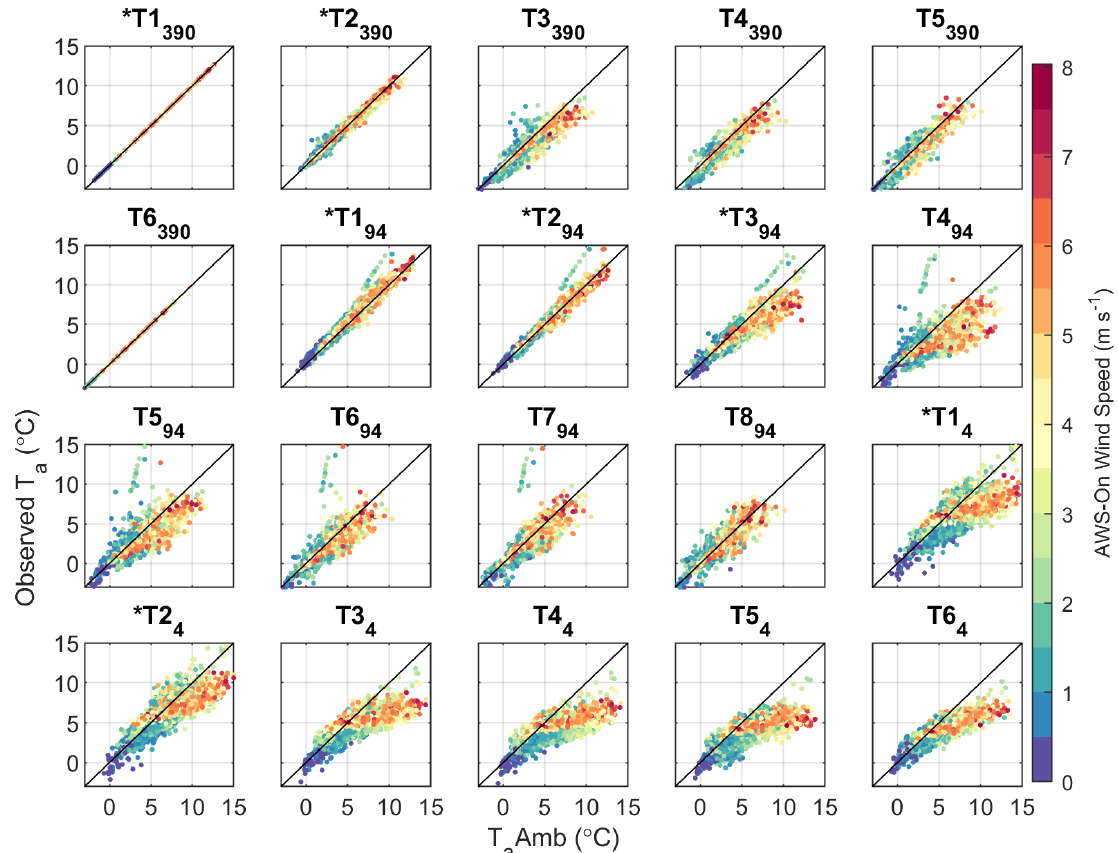
Figure 5. Estimated ( T a Amb) vs. observed T a at each T -logger location (including off-glacier T loggers). Individual, hourly values are coloured by the observed wind speeds at AWS_On (Parlung4). ∗ denotes stations that are off